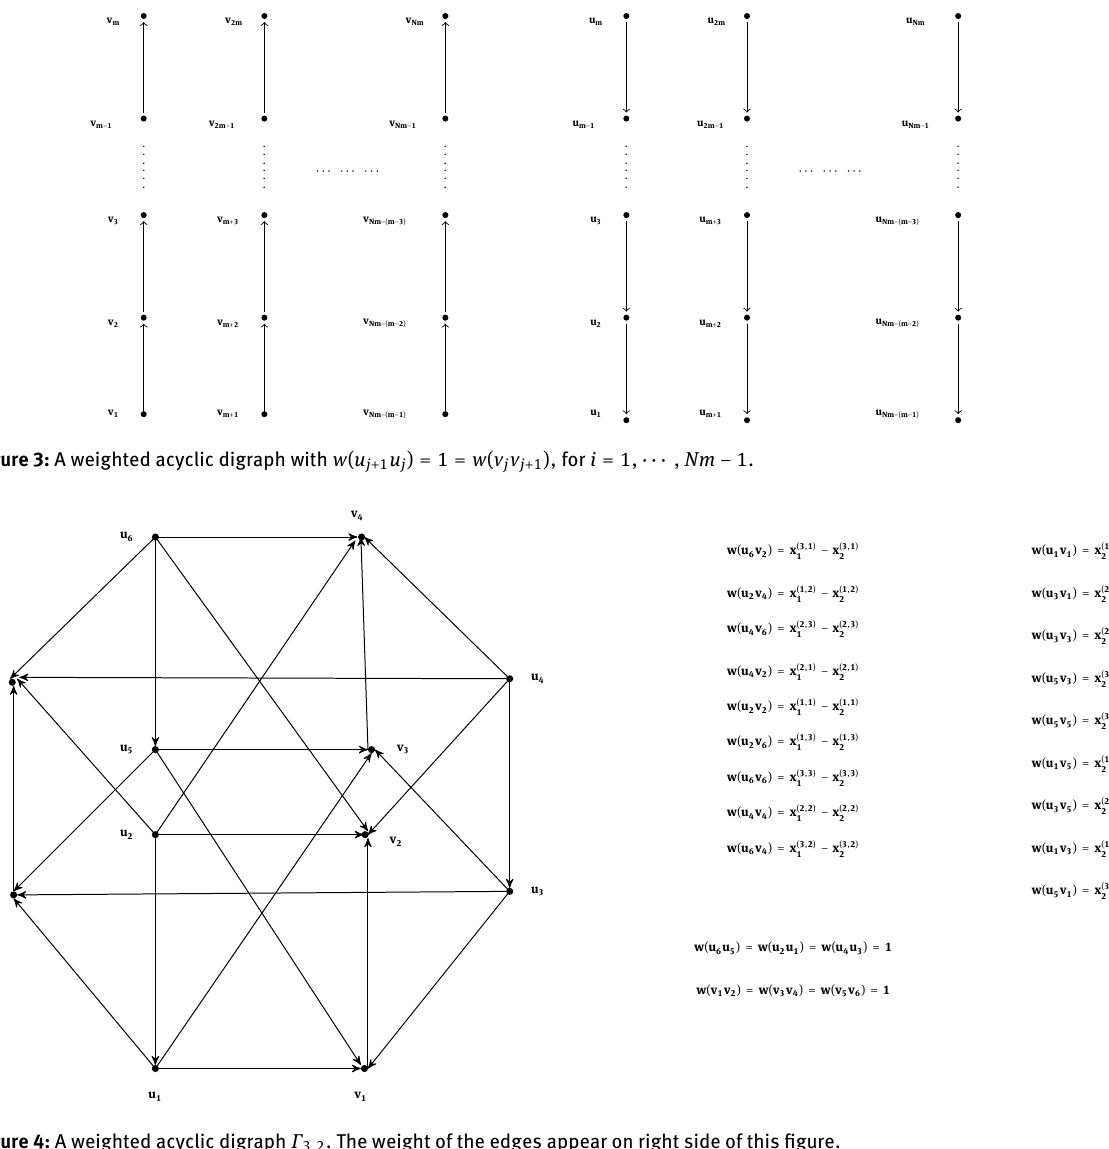
Figure 4: A weighted acyclic digraph Γ 3,2 . The weight of the edges appear on right side of this figure.